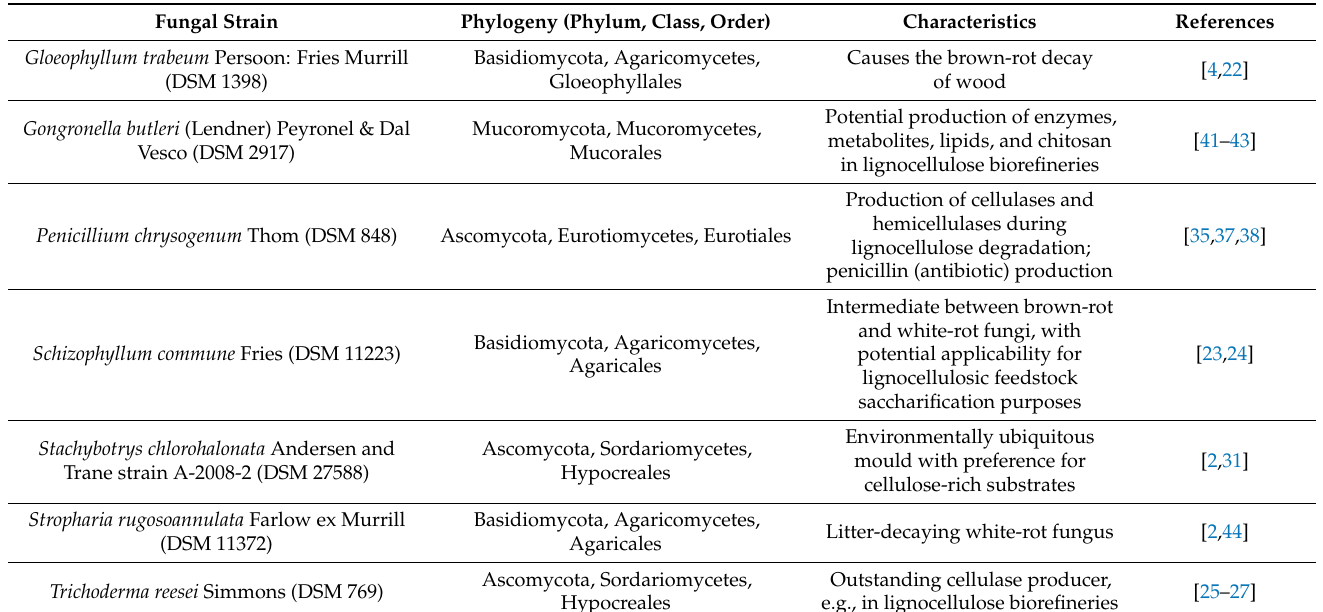
Table 1. Overview of the fungal strains employed in the present